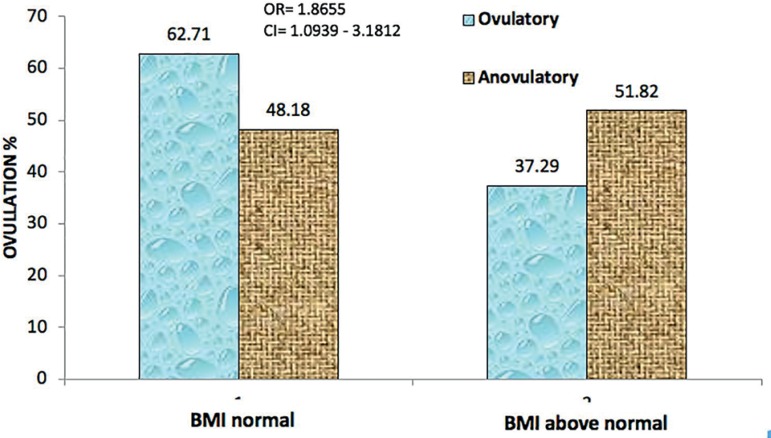
Flow chart assessing the presence of ovulation in overweight and normal
individuals. Lab Rep HC-UFG 2016